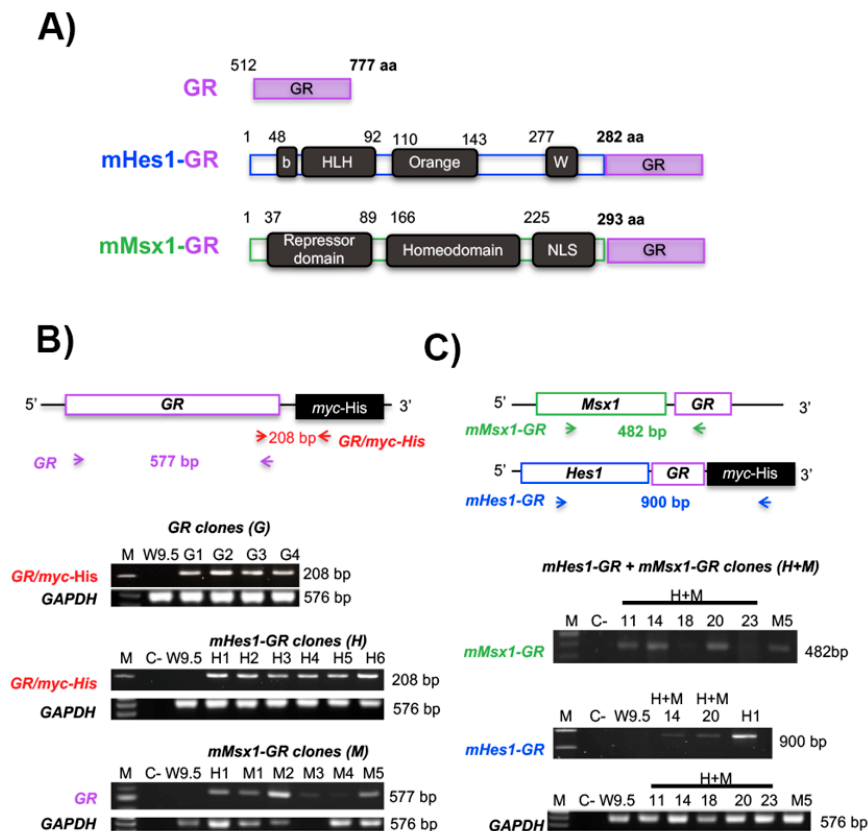
Figure 3. Generation of transgenic mouse embryonic stem cells that express Hes1 and Msx1 . ( A ) Scheme of the ligand binding domain of human glucocorticoid receptor (GR) that served as the control. The full-length cDNA of Hes1 and Msx1 was cloned in-frame with GR to produce Hes1 -GR (HGR) or Msx1 -GR (MGR) vectors. ( B ) After electroporation and selection of mouse embryonic stem cells transfected with the different plasmids, the cells were genotyped via PCR analysis of genomic DNA with the indicated primers, indicated by arrows. The GR fragment was identified with 2 different sets of primers to identify clones, which were designated G. For cells electroporated with the Msx1 -GR or Hes1 -GR plasmids, several positive clones were identified and designated H or M, respectively. ( C ) Embryonic stem cells were transfected with both Hes1 -GR and Msx1 -GR plasmids. To identify the double-positive clones (H+M), the indicated primers were used. Clones 14 and 20 incorporated both constructs. Genomic DNA of W9.5 mouse embryonic stem cells was used as a negative control. (C-) indicates a negative control consisting of water in place of DNA in the PCR